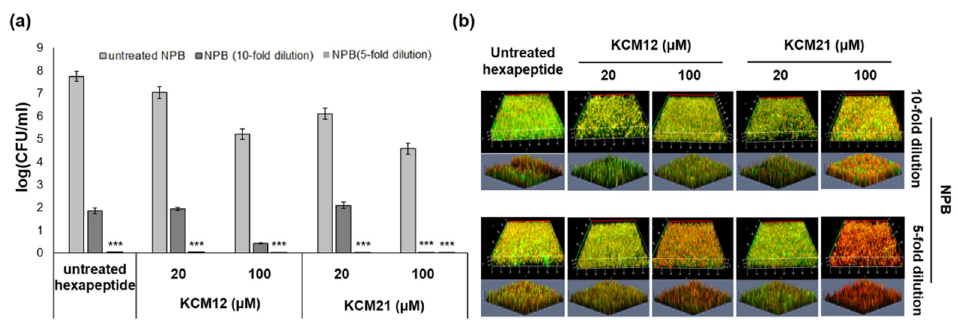
Figure 6. Evaluation of antibacterial and antibiofilm effect of combined treatment with NPB and hexapeptide in ( a ) free-living bacteria, and ( b ) biofilms of Pst DC3000. (* significant at p ≤ 0.05 between control (0 µM) and KCM12- or KCM21-treatment ** significant at p ≤ 0.01 and *** significant at p ≤ 0.001).